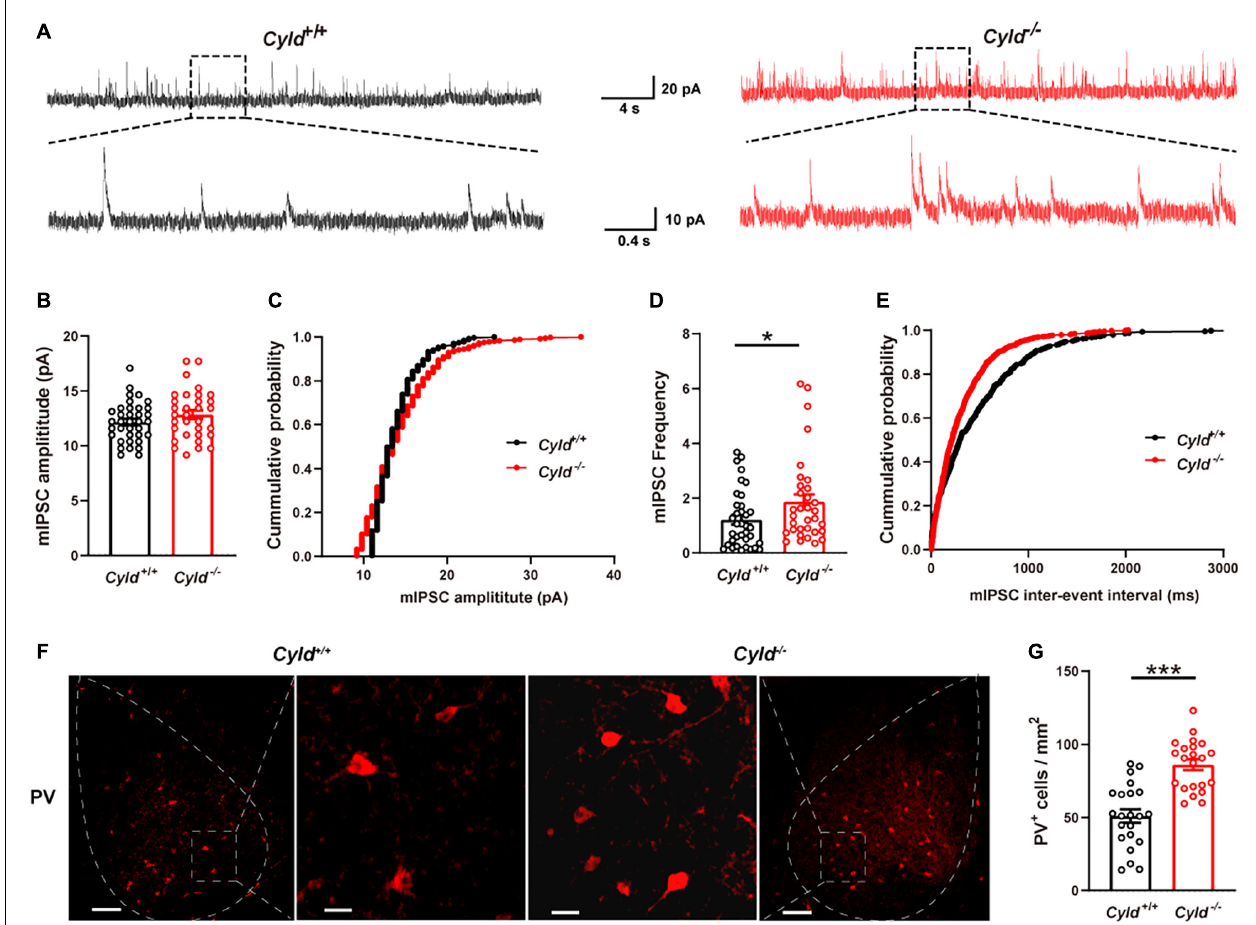
FIGURE 5 | Excessive inhibitory activity in the BLA of Cyld − / − mice. (A) Representative mIPSC traces continuously recorded from BLA principal neurons. Average amplitude (B) and cumulative probability of amplitude (C) of mIPSCs in BLA principal neurons. n = 36 neurons from six mice for the WT group, and n = 32 neurons from four mice for the Cyld knockout group. Average frequency (D) and cumulative probability of the interevent intervals (E) of mIPSCs in BLA principal neurons. n = 36 neurons from six mice for the Cyld + / + group, and n = 33 neurons from four mice for the Cyld knockout group. (F) Representative images of parvalbumin-expressing interneurons in the BLA of Cyld + / + and Cyld − / − mice. Scale bar: 100 µ m. For enlarged images of areas in dotted square, scale bar = 20 µ m. (G) Quantitative analysis showed that the number of PV + neurons in BLA was significantly increased. n = 22 slices from eight mice for each group. Student’s t -test, * p < 0.05, *** p < 0.001. Data are presented as mean ±